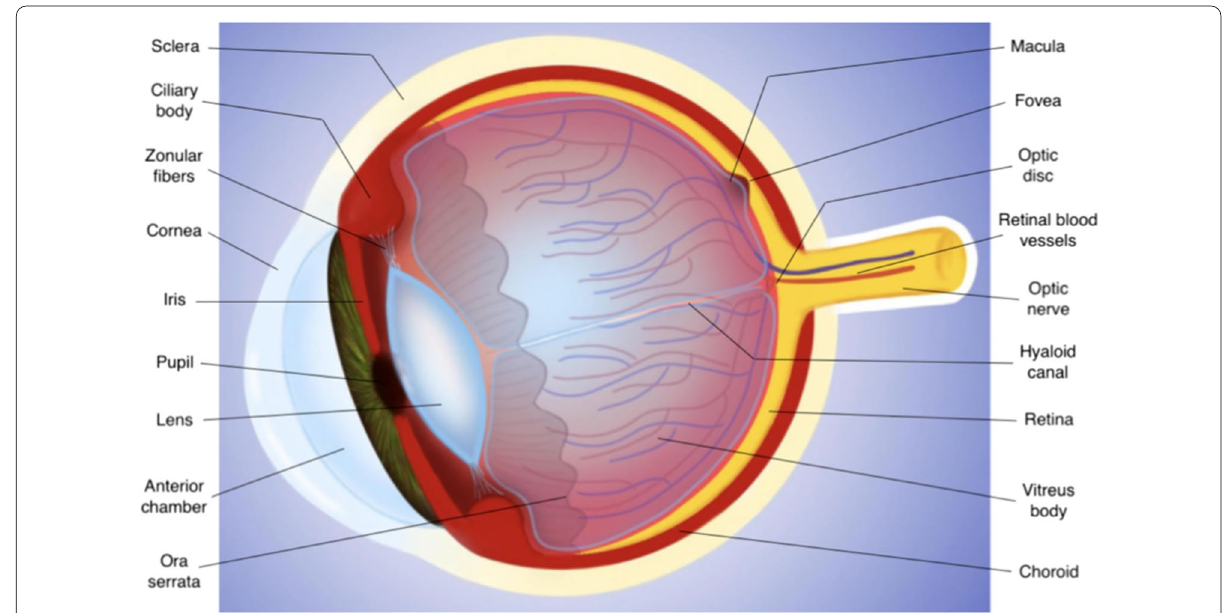
Fig. 3 Drawing of the eye anatomy in the midsagittal section